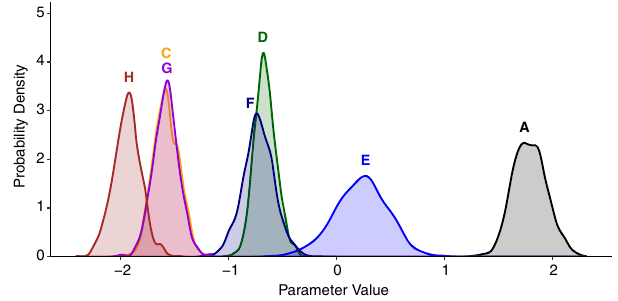
FIG. 5. Enlarged version of the right side of Fig. 4. These distributions represent about 1% of the total results. The overall shapes and locations of the parameter distributions are similar to Fig. 2.